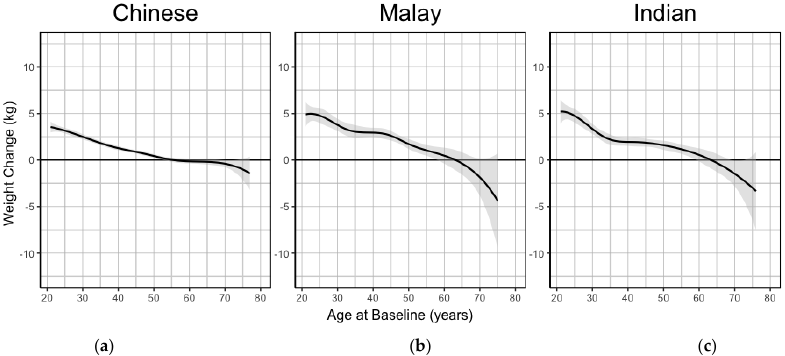
Figure 1 . Weight change during follow-up according to baseline age in different ethnic groups among Singapore Multi-Ethnic Cohort participants aged 21 years and above. ( a ) Chinese partici- pants; ( b ) Malay participants; ( c ) Indian participants.